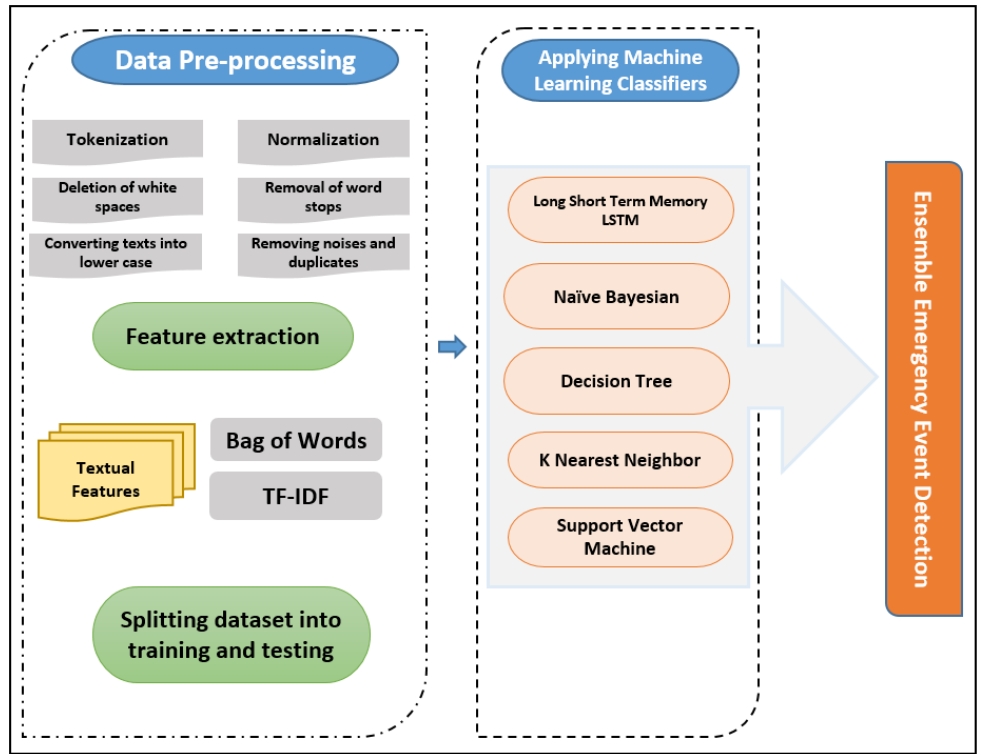
Figure 4. The proposed steps of the emergency event detection ensemble